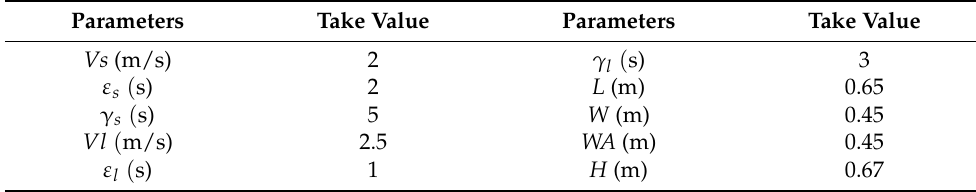
Table 10. System